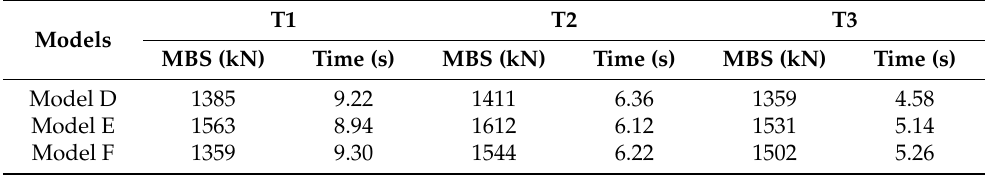
Table 8. The maximum base shear in the X-direction.